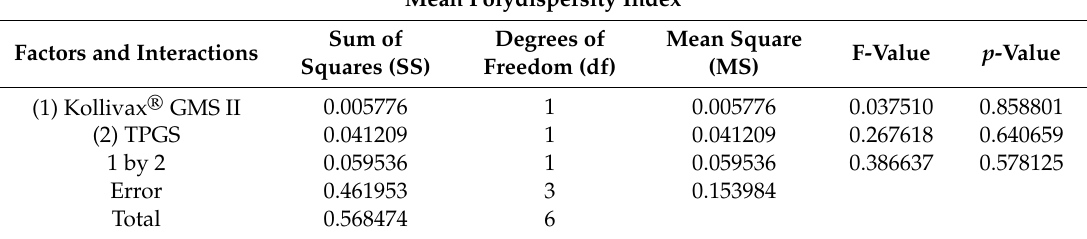
Table 9. Analysis of the mean polydispersity index by ANOVA statistical test. Determination coe ffi cient (R 2 ) = 0.18738.